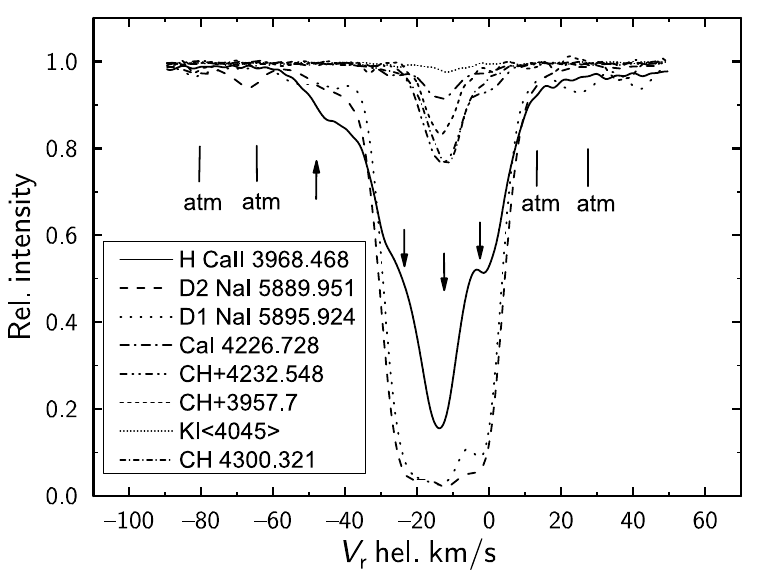
Fig. 1. Profiles of interstellar lines in the optical spectra of Cyg X-1, obtained with the 6 m telescope: relative intensity vs. heliocentric radial velocity V rhel . The inset identifies curves used for different species. Labels ‘atm’ mark the positions of the telluric H 2 absorption lines in the D1 and D2 Na I line profiles. Arrows indicate radial velocities of the main components of the interstellar line